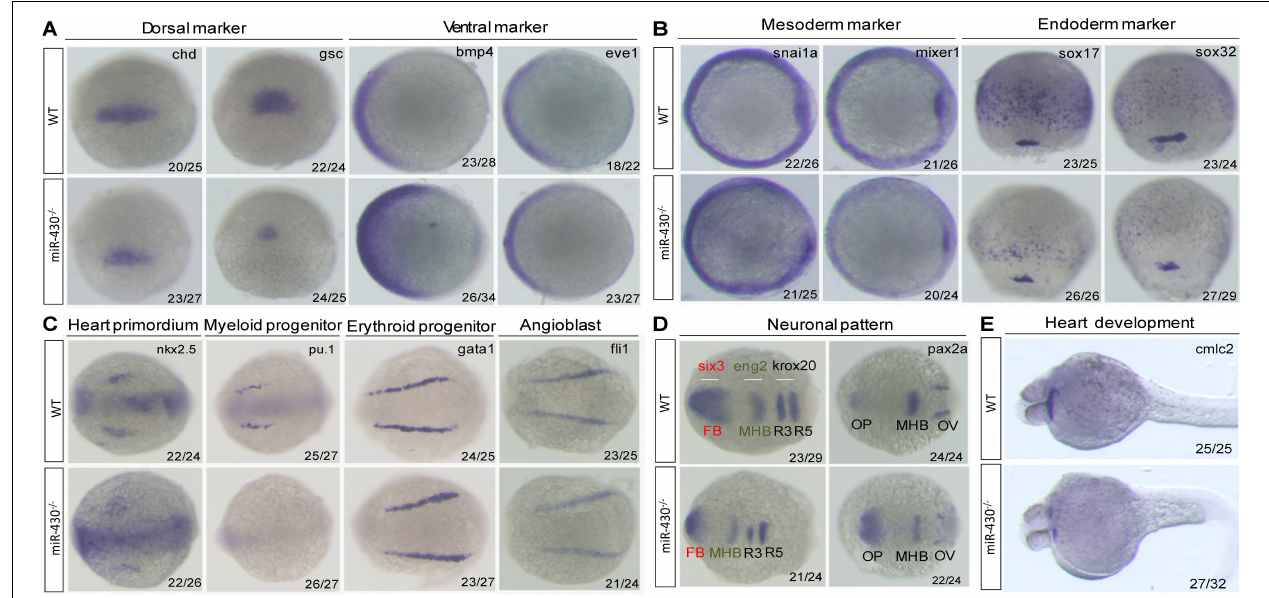
FIGURE 3 | Marker gene analysis. Marker gene expression of the WT and miR-430 − / − mutant was analyzed at shield stage (A) , 75% epiboly (B) , 6-somite (C,D) , and 36 hpf (E) . Marker genes of axis formation (A) , germ layer formation (B) , organ progenitor formation, (C) neuronal pattern (D) , and heart formation (E) were analyzed in the miR-430 − / − mutants. The ratios of the observed phenotypes were indicated. FB, forebrain; MHB, midbrain hindbrain boundary; OV, otic vesicle; OP, optic placode; R3, rhombomere 3; R5, rhombomere